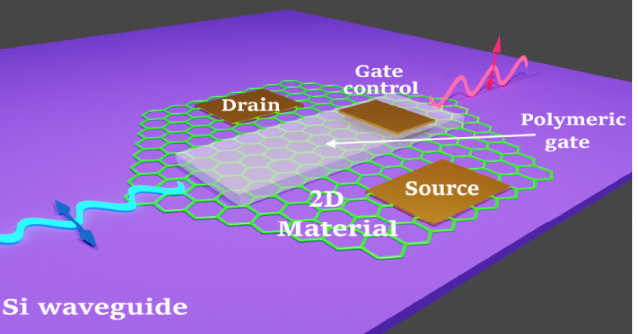
Figure 1. Pictorial view of a nanodevice architecture that may act as the building block for the envisioned 2D material-based polarization processor. The two-dimensional material (graphene) lies on the Si waveguide and is coupled to it. In addition, it can be electrically contacted by two ohmic contacts (source–drain) and equipped with a soft-matter component enabling the ionic gate control of the chemical potential in the